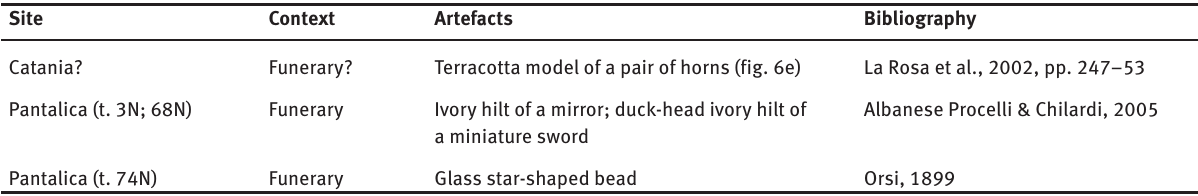
Table 9: Terracotta and Luxury Artefacts of Mycenaean Origin in Late Bronze Age Sicily and